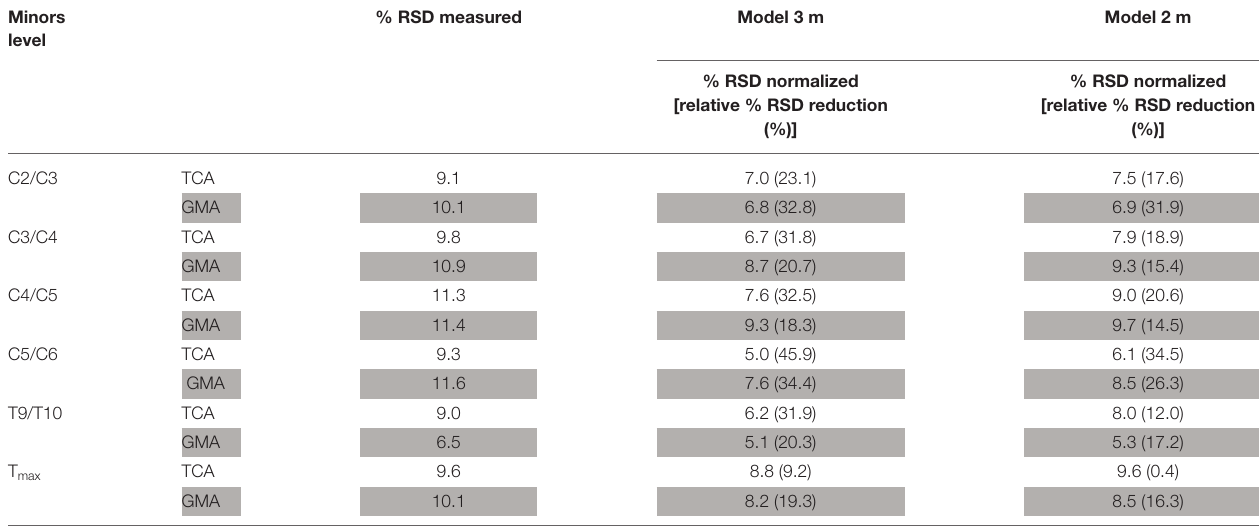
TABLE 6 | Performance of normalization by Model 3m and Model 2m for total cross-sectional cord areas (TCA) and gray matter areas (GMA) at all other cord levels in